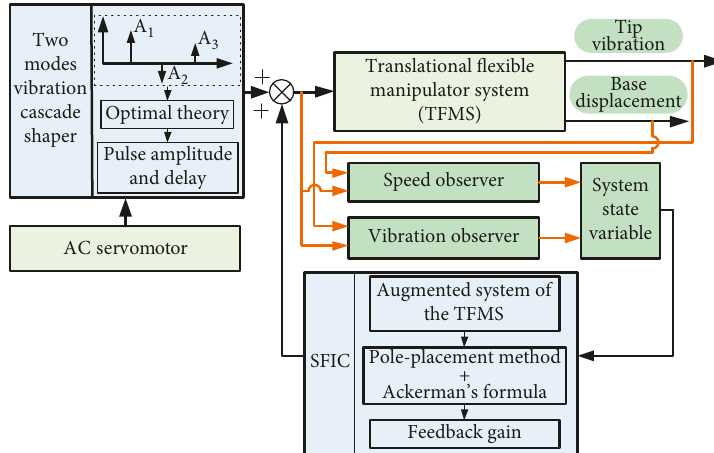
Figure 3: Elastic vibration integrated controller of the